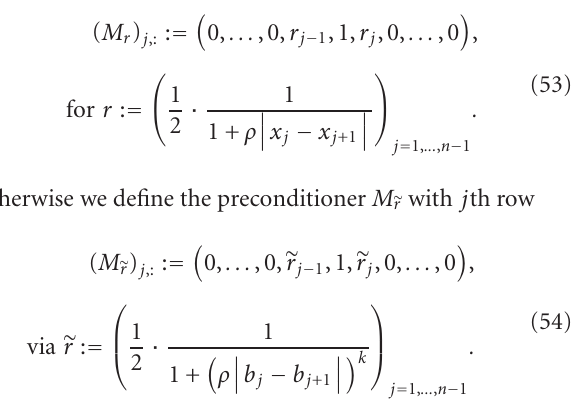
Table 5: Optimal reconstruction error (cid:2) p − (cid:4) p (cid:2) for the problem of [24] invoked with (cid:0)(cid:2)(cid:3)(cid:4) noise of order 0.01%, 0.1%, 1%, and 10%. Subspace weight is ρ =